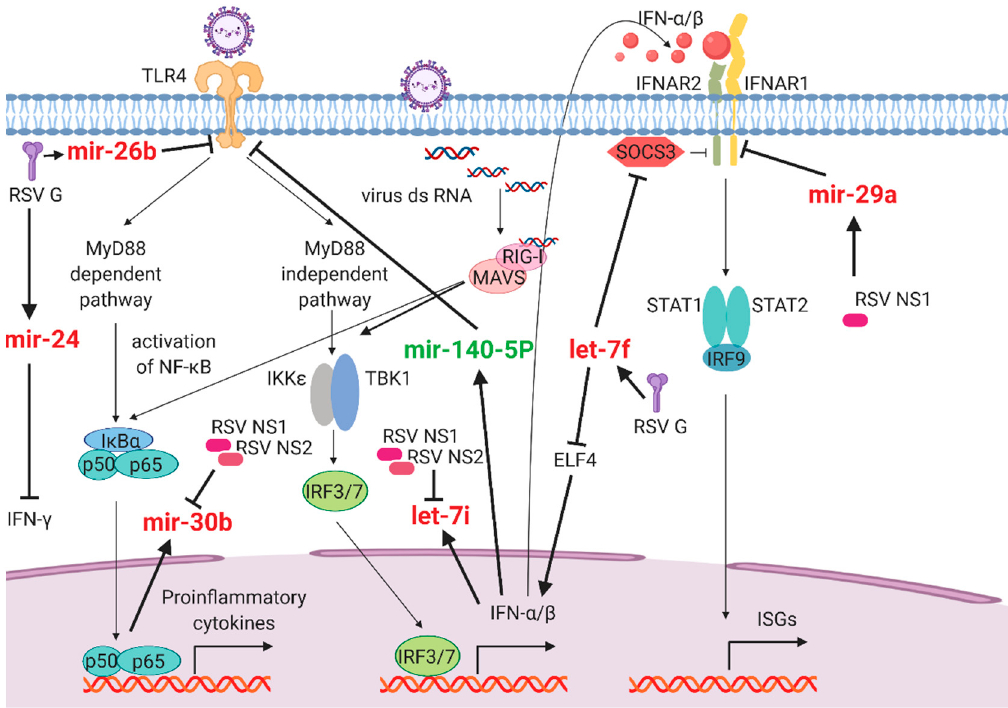
Figure 1. Schematic diagram of the respiratory syncytial virus (RSV)-mediated microRNAs (miRNAs)-messenger RNA (mRNA) interaction networks involved in inflammatory responses. The RSV-increased miRNAs are indicated in red, the decreased miRNAs by RSV are shown in green. Arrows mark the positive effects between elements, whereas stop bars denote inhibitory effects.